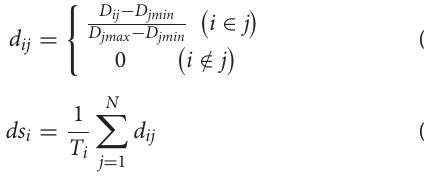
Frontiers in Bioengineering and Biotechnology |